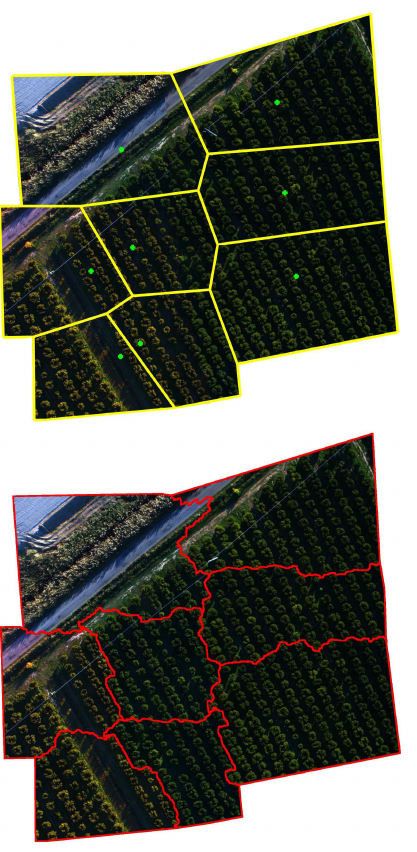
Figure 6. Seams produces by Voronoi tessellation (top) and after optimisation.